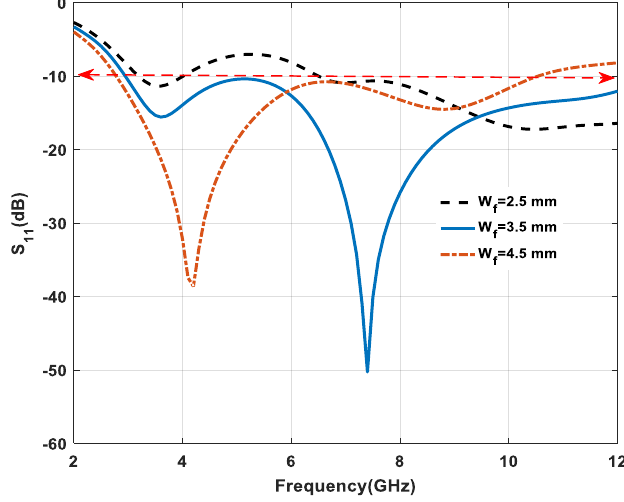
Figure 8. Effect of variation on feed width W f .